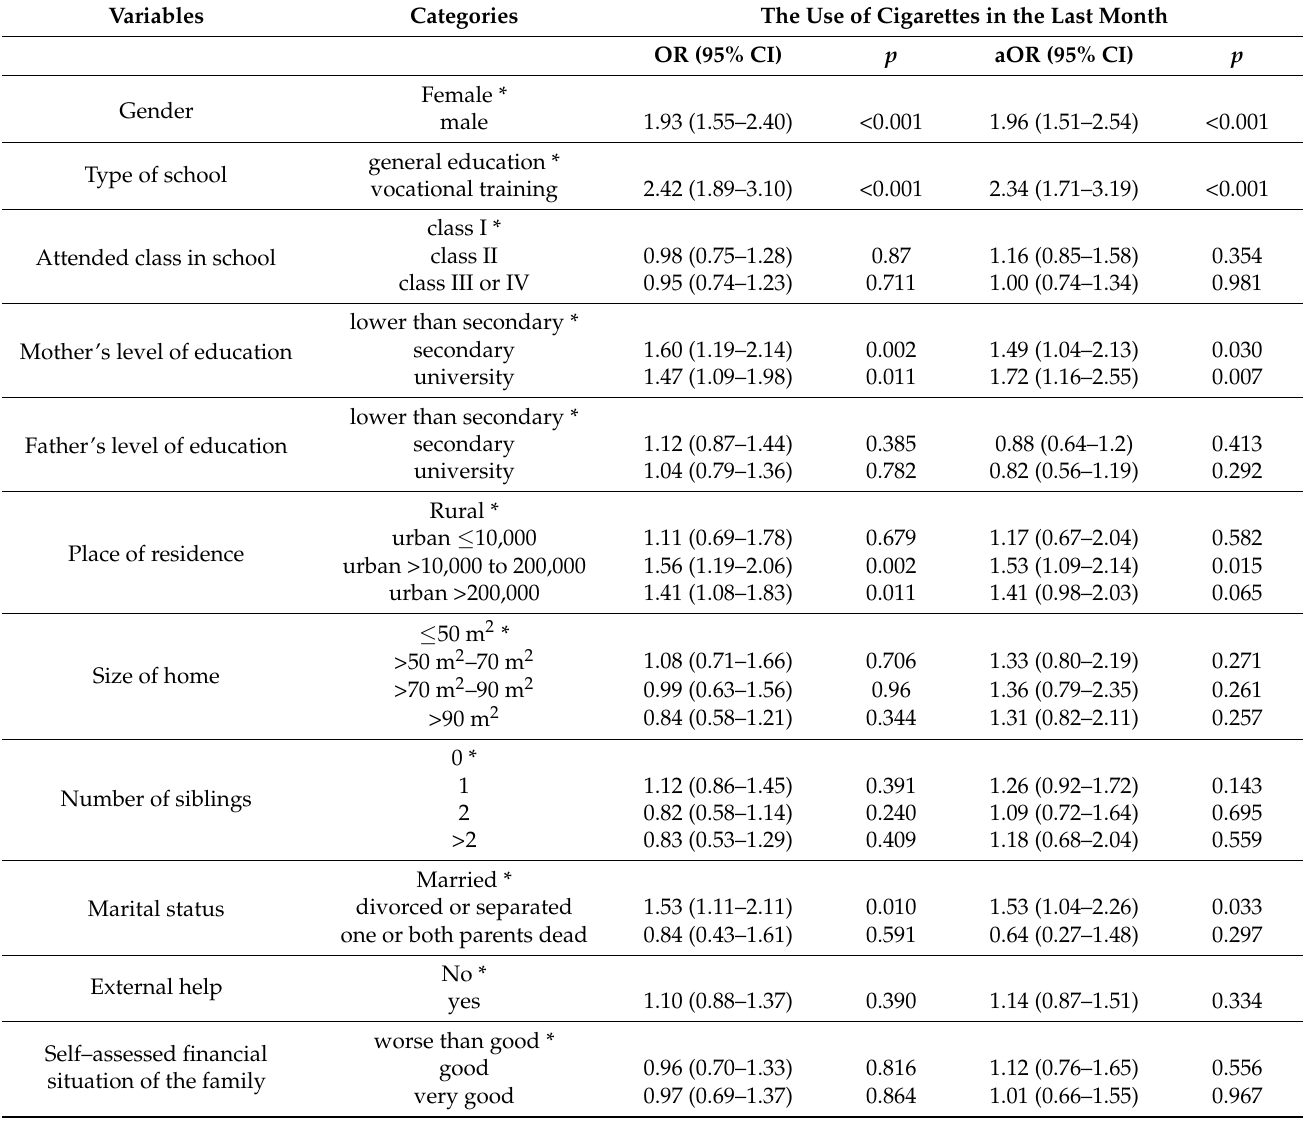
Table 3. Uni- and multivariate logistic regression models for the use of cigarettes in the last